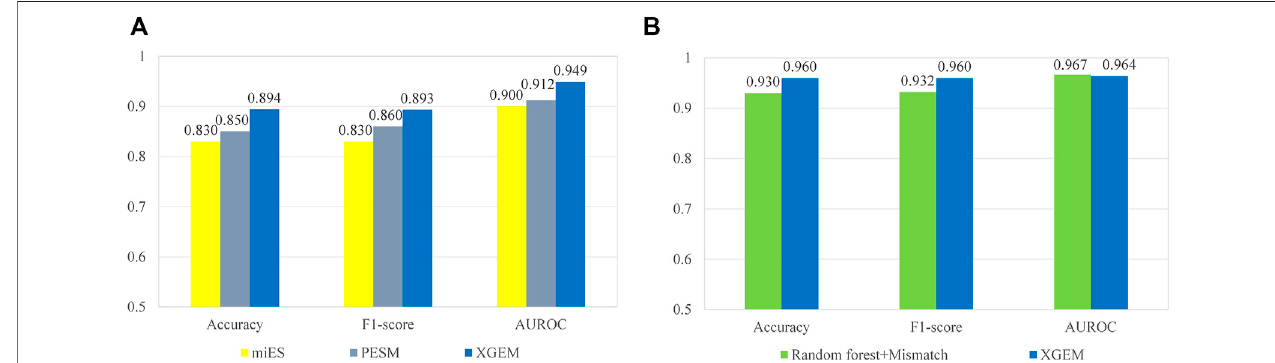
FIGURE6| Comparisonofdifferentmethodsonmousepre-miRNAdatasets.Theaccuracy,F1-score,andAUROCarecompared. (A) Acomparisonbetweenthe XGEM, miES, and PESM method on the miES-PESM dataset; (B) A comparison between XGEM and Ru ’ s work on Ru ’ s